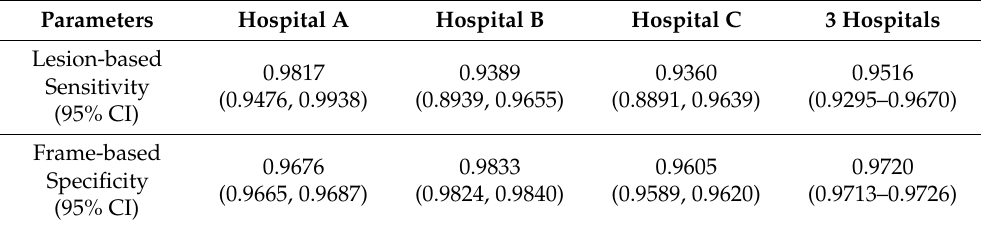
Table 3. Model benchmark using prospective approach for polyps detection.